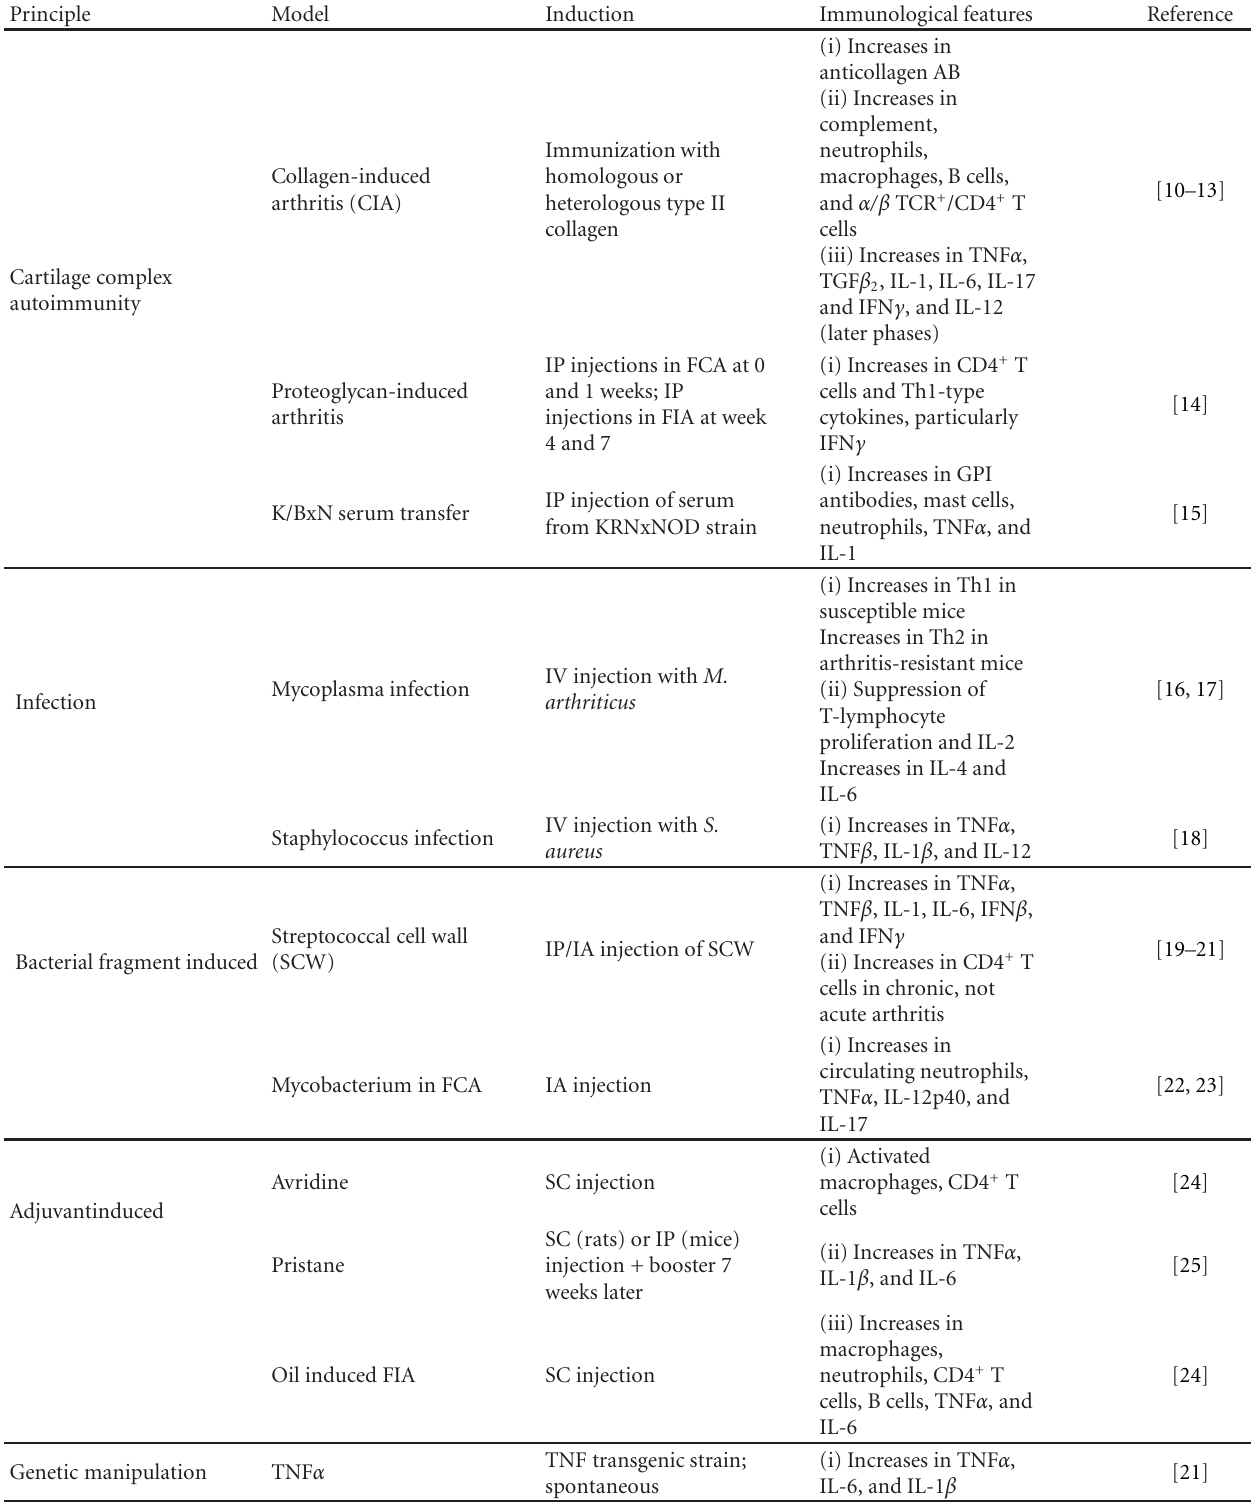
Table 1: Summary of some of the most common rodent models of musclo-skeletal